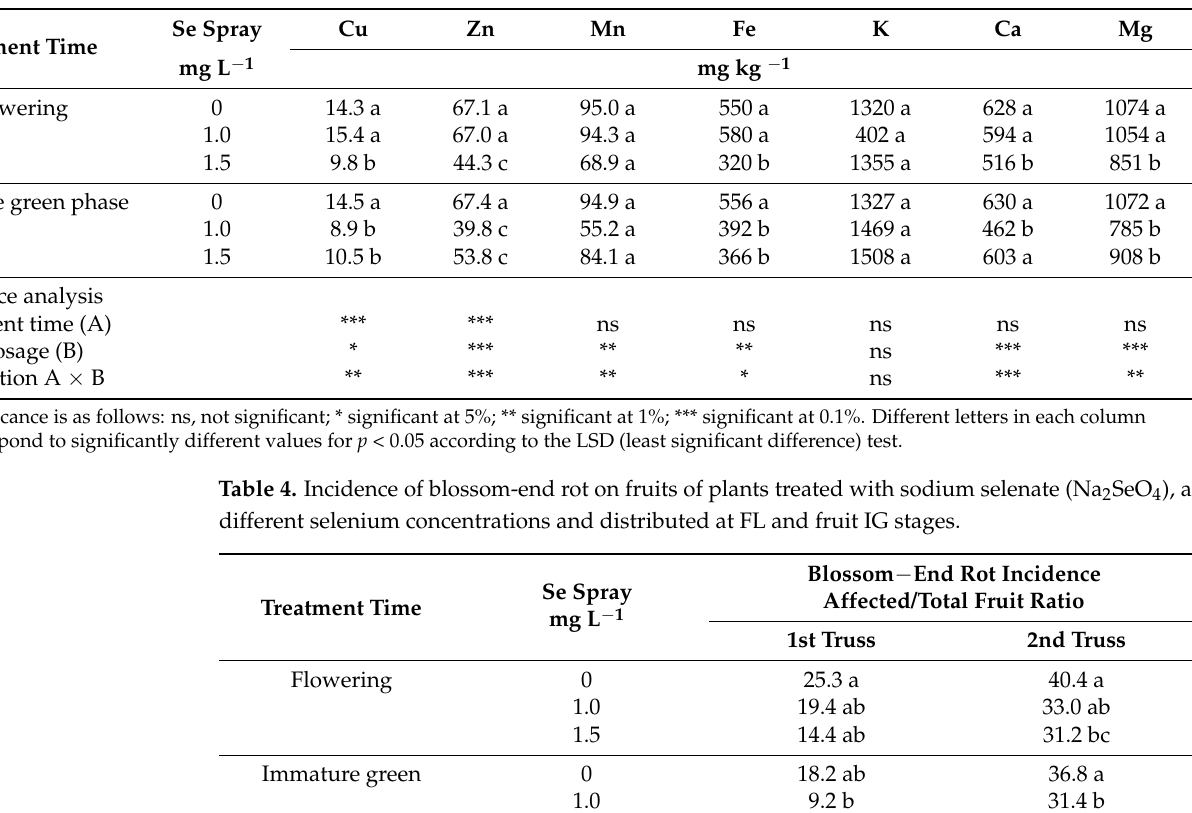
Table 3. Macro and microelements concentration (mg kg –1 ) in tomato fruit of the second truss treated with sodium selenate (Na 2 SeO 4 ) at different concentrations of Se at FL and fruit IG stages.